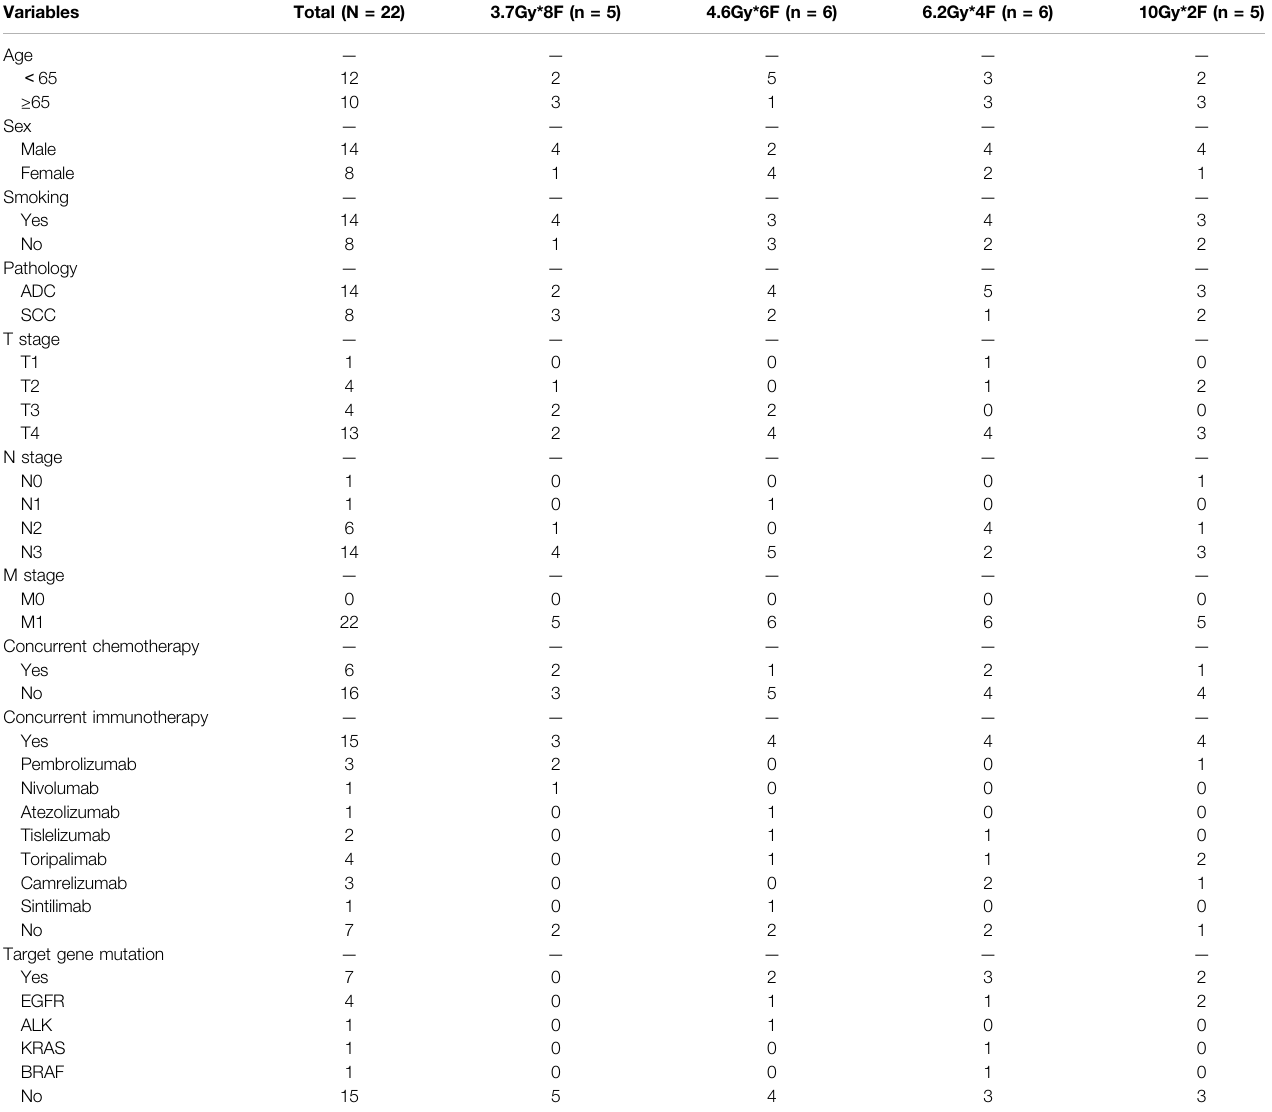
TABLE 1 | Demographics and clinical characteristics in different fractionations of NSCLC patients. Variables